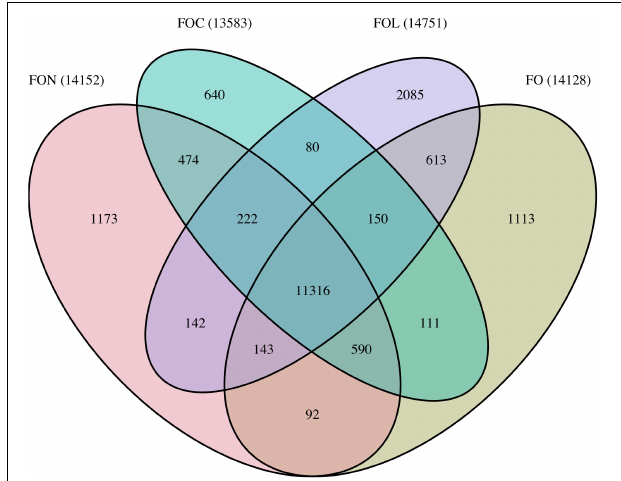
FIGURE 4 | Summary of shared and unique orthogroups between FON, FOC, FOL and FO genomes. Bracketed numbers indicate the total number of orthogroups for each